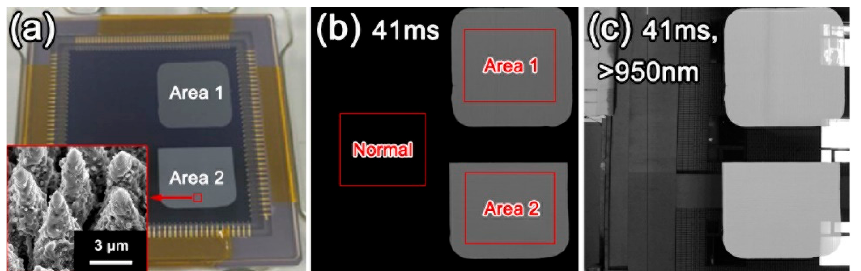
Figure 1. ( a ) Photograph of CMOS image sensor irradiated by fs-laser. ( b ) Gray value measurements of laser-microstructured areas (marked as Area 1 and Area 2) and unprocessed area (marked as Normal) of CMOS image sensor at an integration time of 41 ms. ( c ) Comparison of near-infrared imaging performance between microstructured area and unprocessed area of CMOS image sensor at an integration time of 41 ms. The imaging conditions (shooting time, weather, location, and light intensity) are 9 pm, cloudy, outdoor, and weak light intensity.